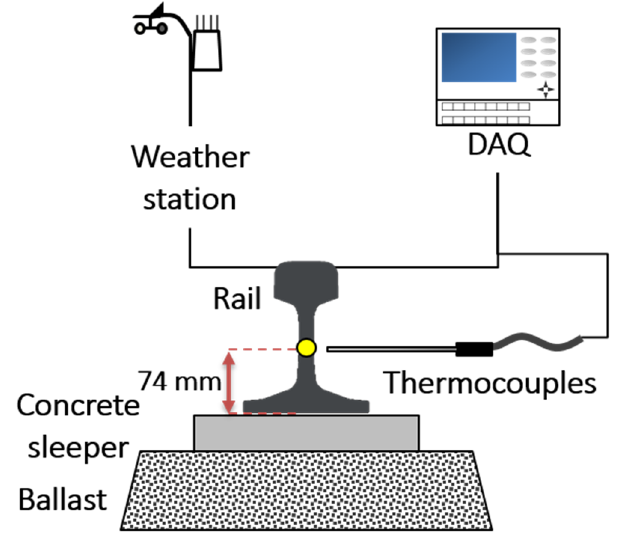
Figure 1. Schematic of the measurement system.